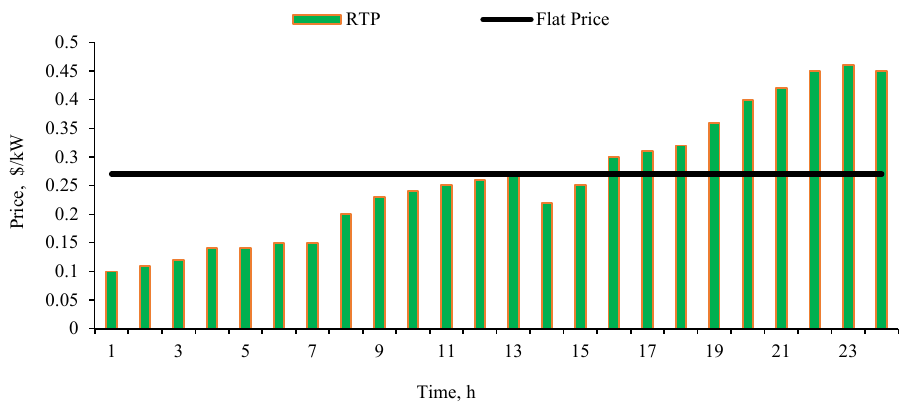
Fig. 3. RTP and Flat Price of electricity sale by DisCo.